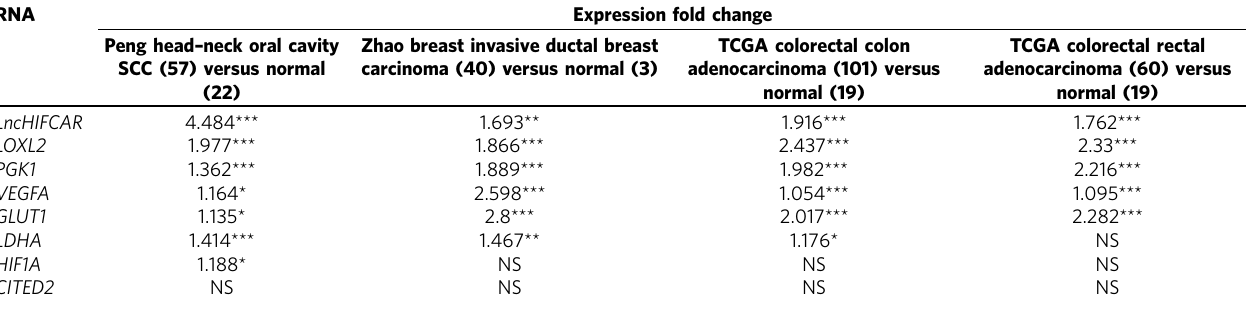
Table 2 | Expression levels of LncHIFCAR and HIF-1 a target genes in normal versus cancer obtained from the Oncomine microarray data